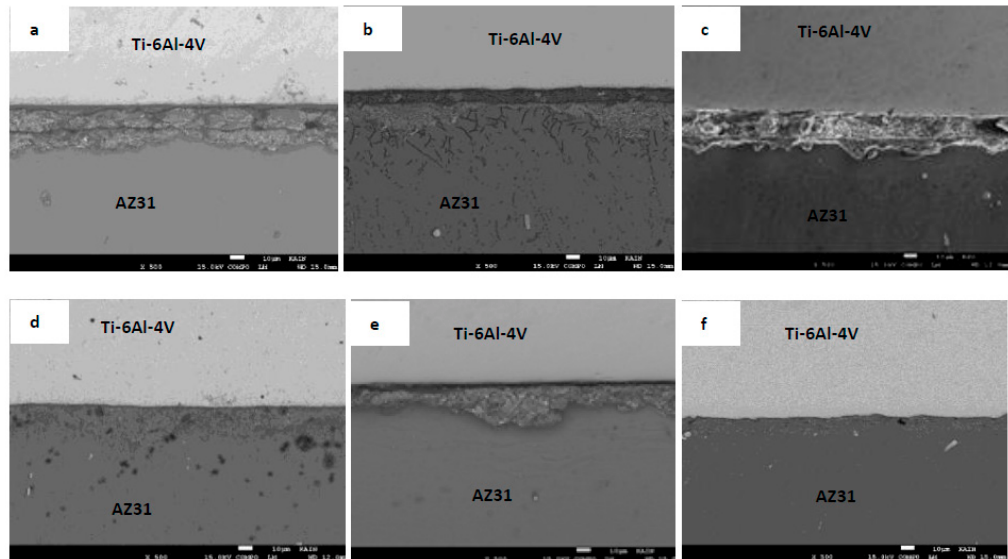
Figure 3. Backscattered SEM images of the joint regions for the bonds made at ( a ) 5, ( b ) 10, ( c ) 15, ( d ) 20, ( e ) 25, and ( f ) 30 min. Scale bar: 10 µm.